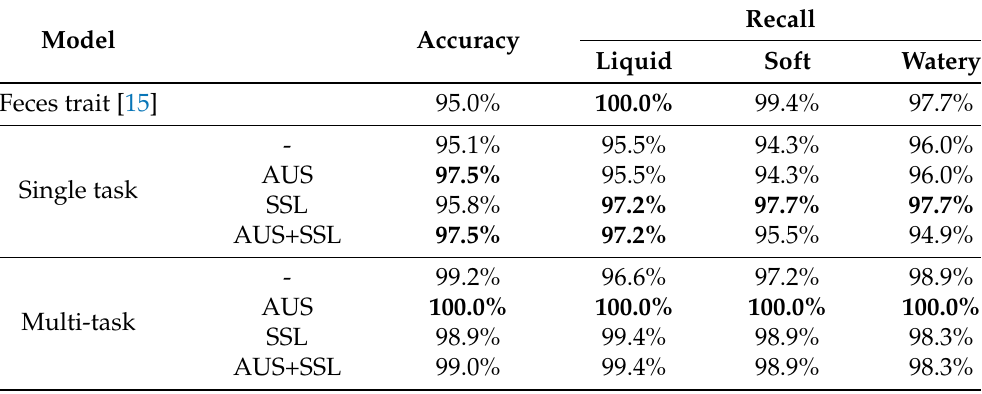
Table 8. Results for three trait categories in real